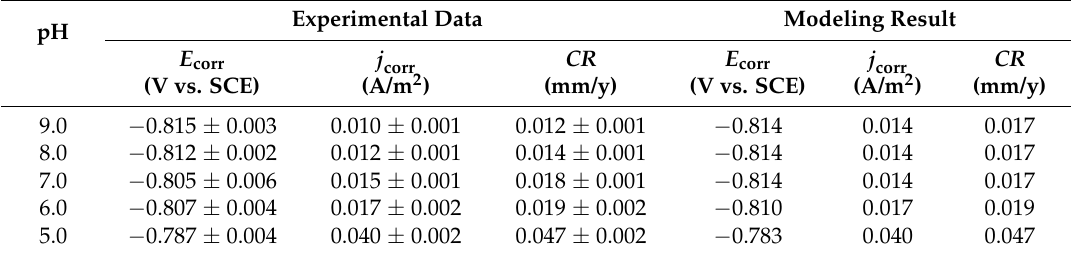
Table 4. The corrosion potential, corrosion current density and corrosion rate of Q345R steel in 1 wt.% NaCl solution with 0.08 mg/L oxygen at different pH under 30 ◦ C, including the results fitted from the experiment data and calculated from the model.